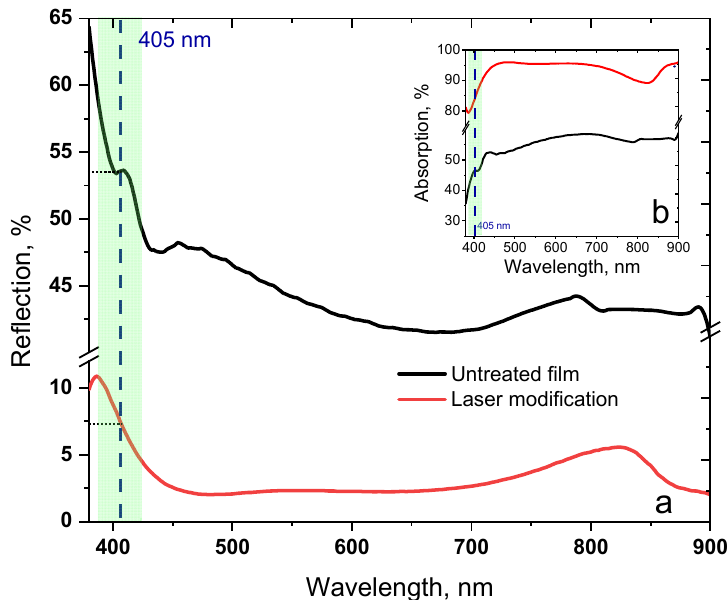
Figure 6. Dependence of ( a ) reflection, ( b ) absorption from wavelength for different PbSe films processing: untreated (black curve), laser modification (red curve).